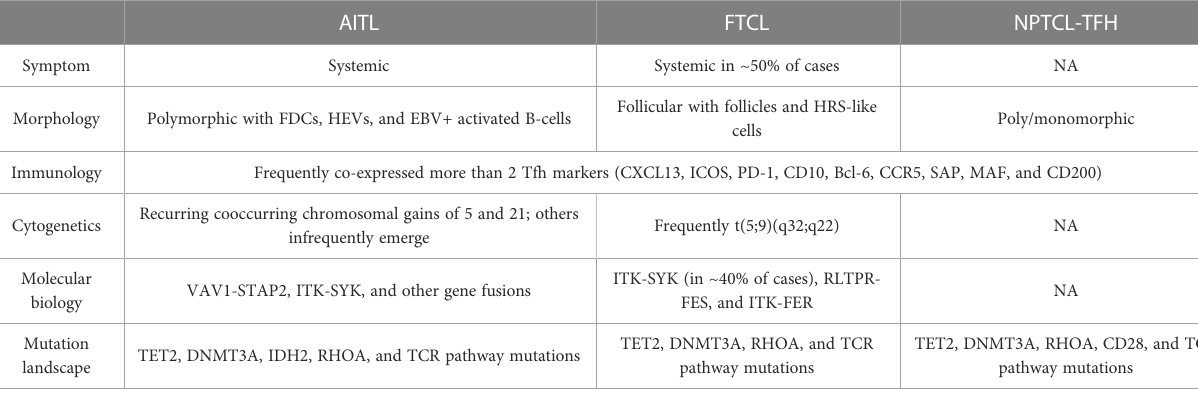
TABLE 1 The characteristics of three entities in T-FHCL (1, 7 – 18).